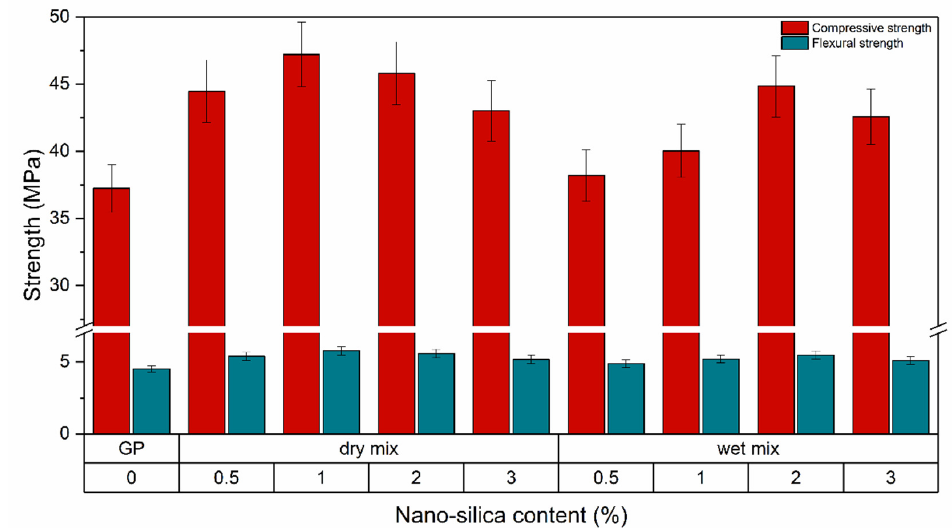
Figure 4. Influence of nano-sillica content on flexural and compressive strength of geopolymer samples according to Reference [14].